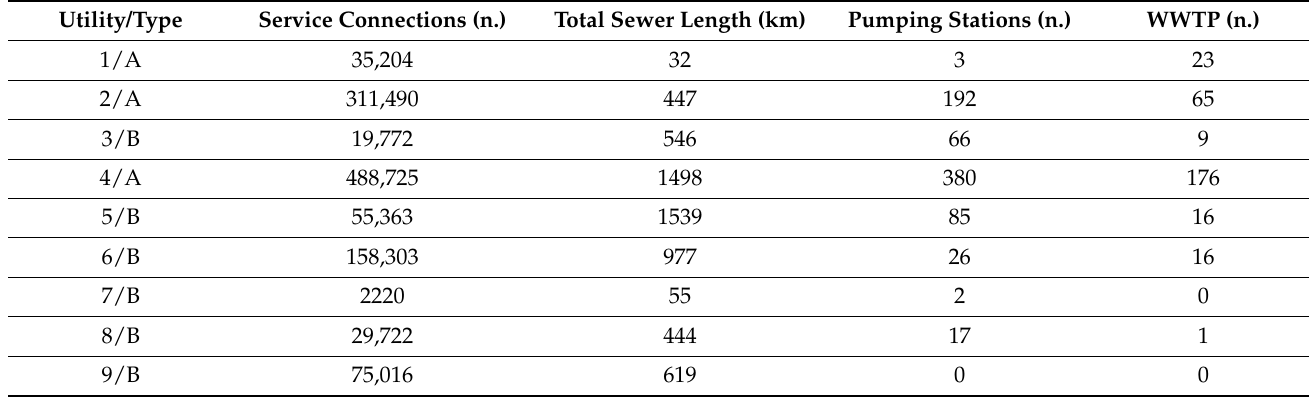
Table 2. Characteristics of systems used in